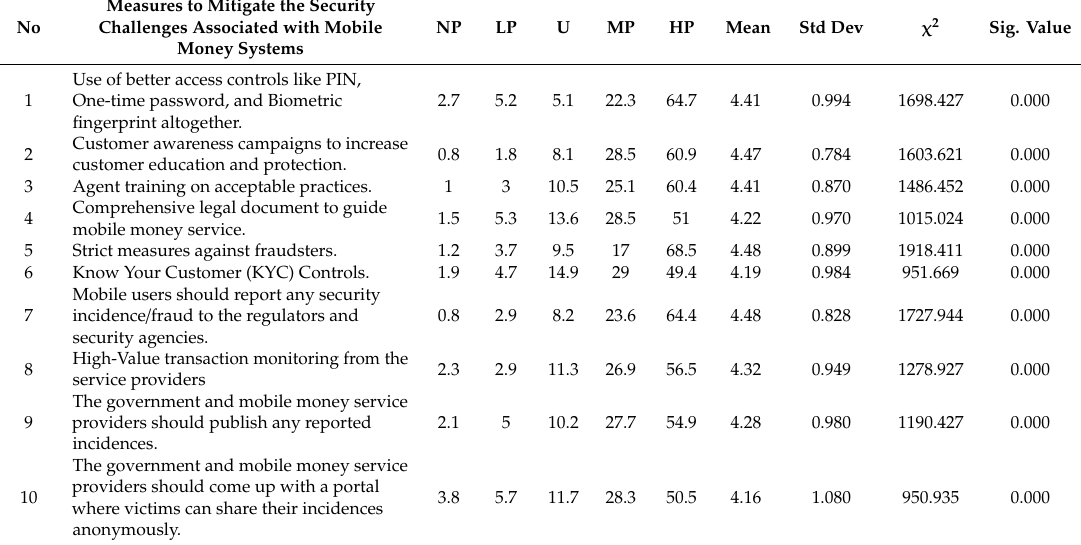
Table 10. Opinion of respondents regarding the di ff erent ways or measures to mitigate the security challenges of mobile money